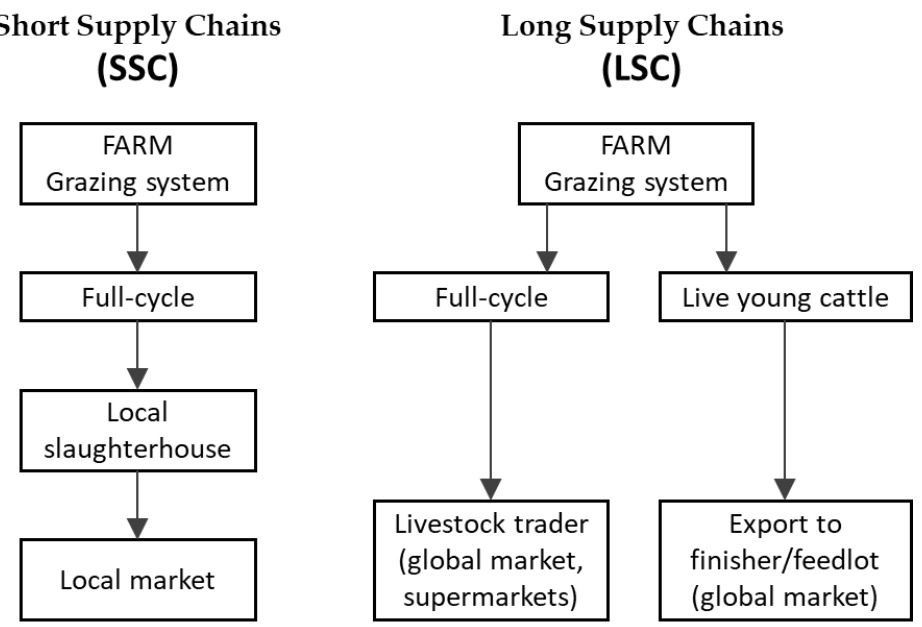
Figure 1. Schema of the type of farms serving short supply chains and long supply chains in the study area around Avignon, France.